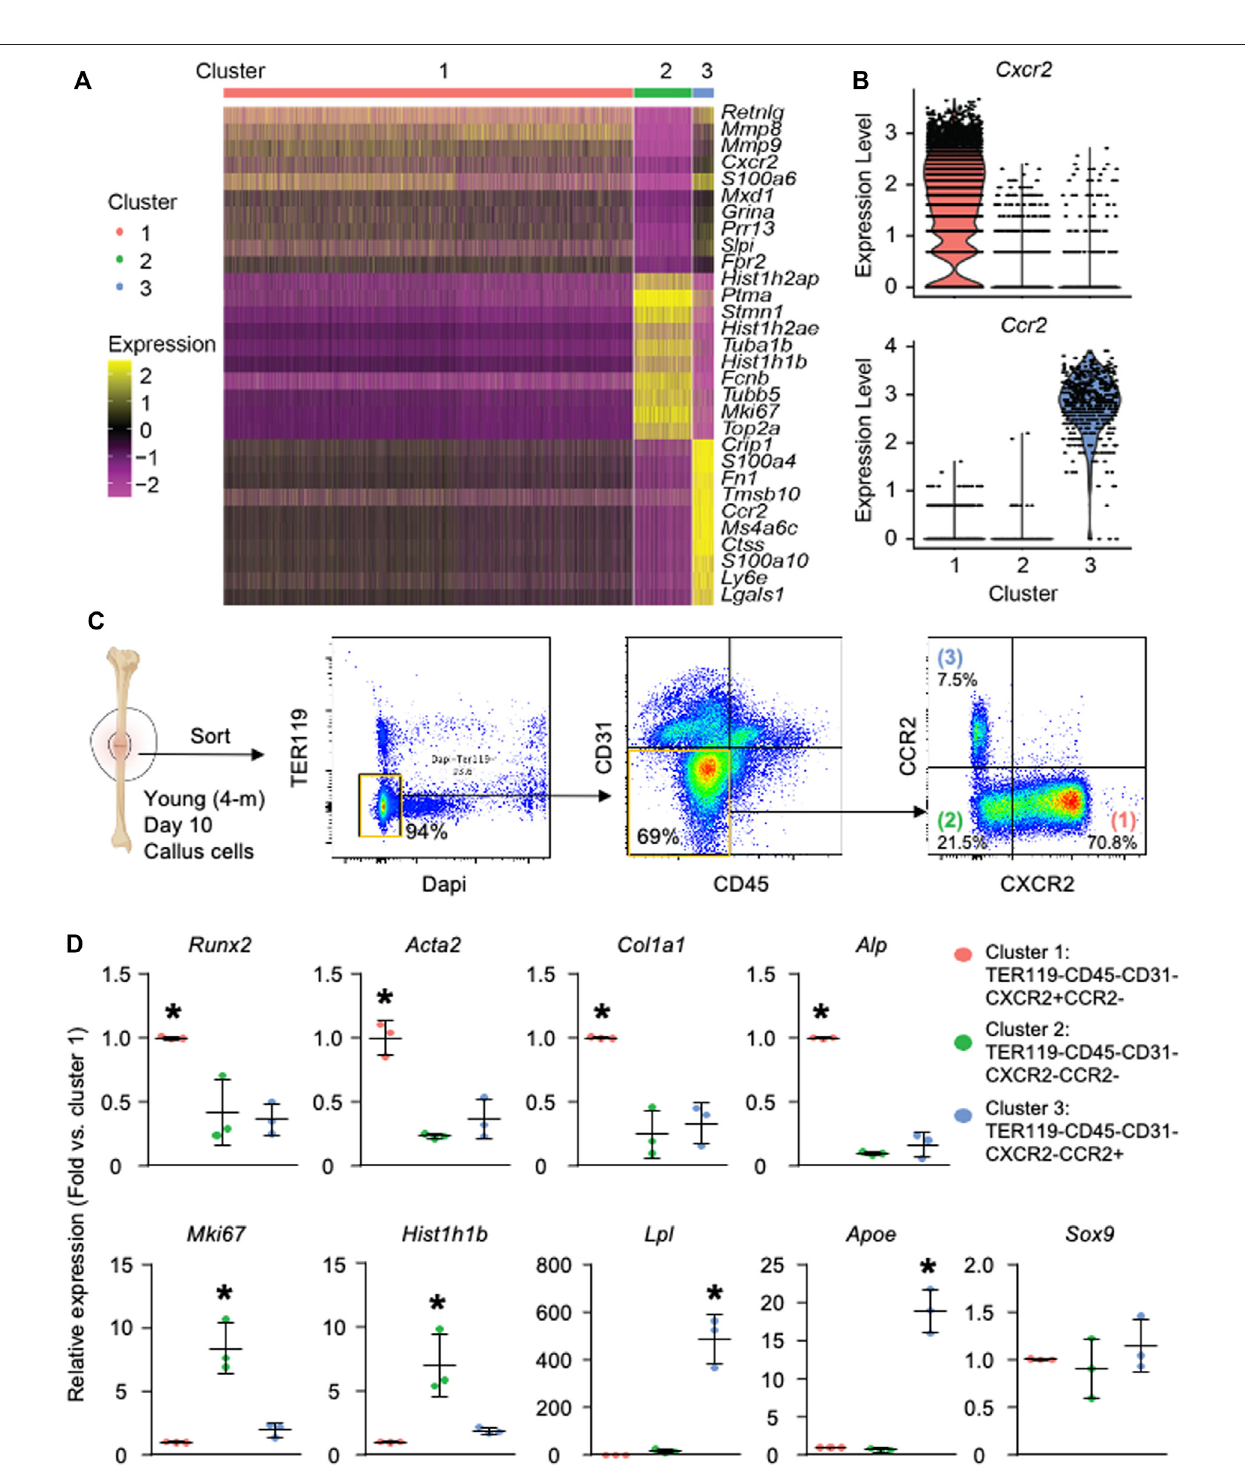
FIGURE 2 | Callus SSPCs are composed of osteogenic, proliferating, and adipogenic clusters. Analysis was performed on clusters 1 – 3. Cluster 4 was excluded from further analysisduetopossiblecontaminationofBcellsduringcellharvest,whichisdescribedin SupplementaryFigureS2 . (A) Heatmapofthetop10DEGsinclusters1 – 3showingcluster 1expressedin fl ammatoryandmatrixrelatedgenes,cluster2expressedproliferatinggenes,andcluster3expressedamiscellanyofin fl ammatory,stemcell-related,andoncogenes. (B) Violinplotoftheexpressionlevelofsurfacemarkers,Cxcr2andCcr2,withinclusters1 – 3. (C) Isolationofclusters1 – 3usingFACSsorting:Cluster1:Dapi-TER119-CD45-CD31- CXCR2+CCR2-; Cluster 2: Dapi-TER119-CD45-CD31-CXCR2-CCR2-; Cluster 3: Dapi-TER119-CD45-CD31-CXCR2-CCR2+. (D) RT-qPCR of cluster 1 – 3 cells to assess their osteogenic,proliferative,andadipogeniccapacity.Datarepresentmean±SD.One-wayANOVAfollowedbyTukeypost-hoc.* p < 0.05forsigni fi cantdifferencefromanyotherclusters.